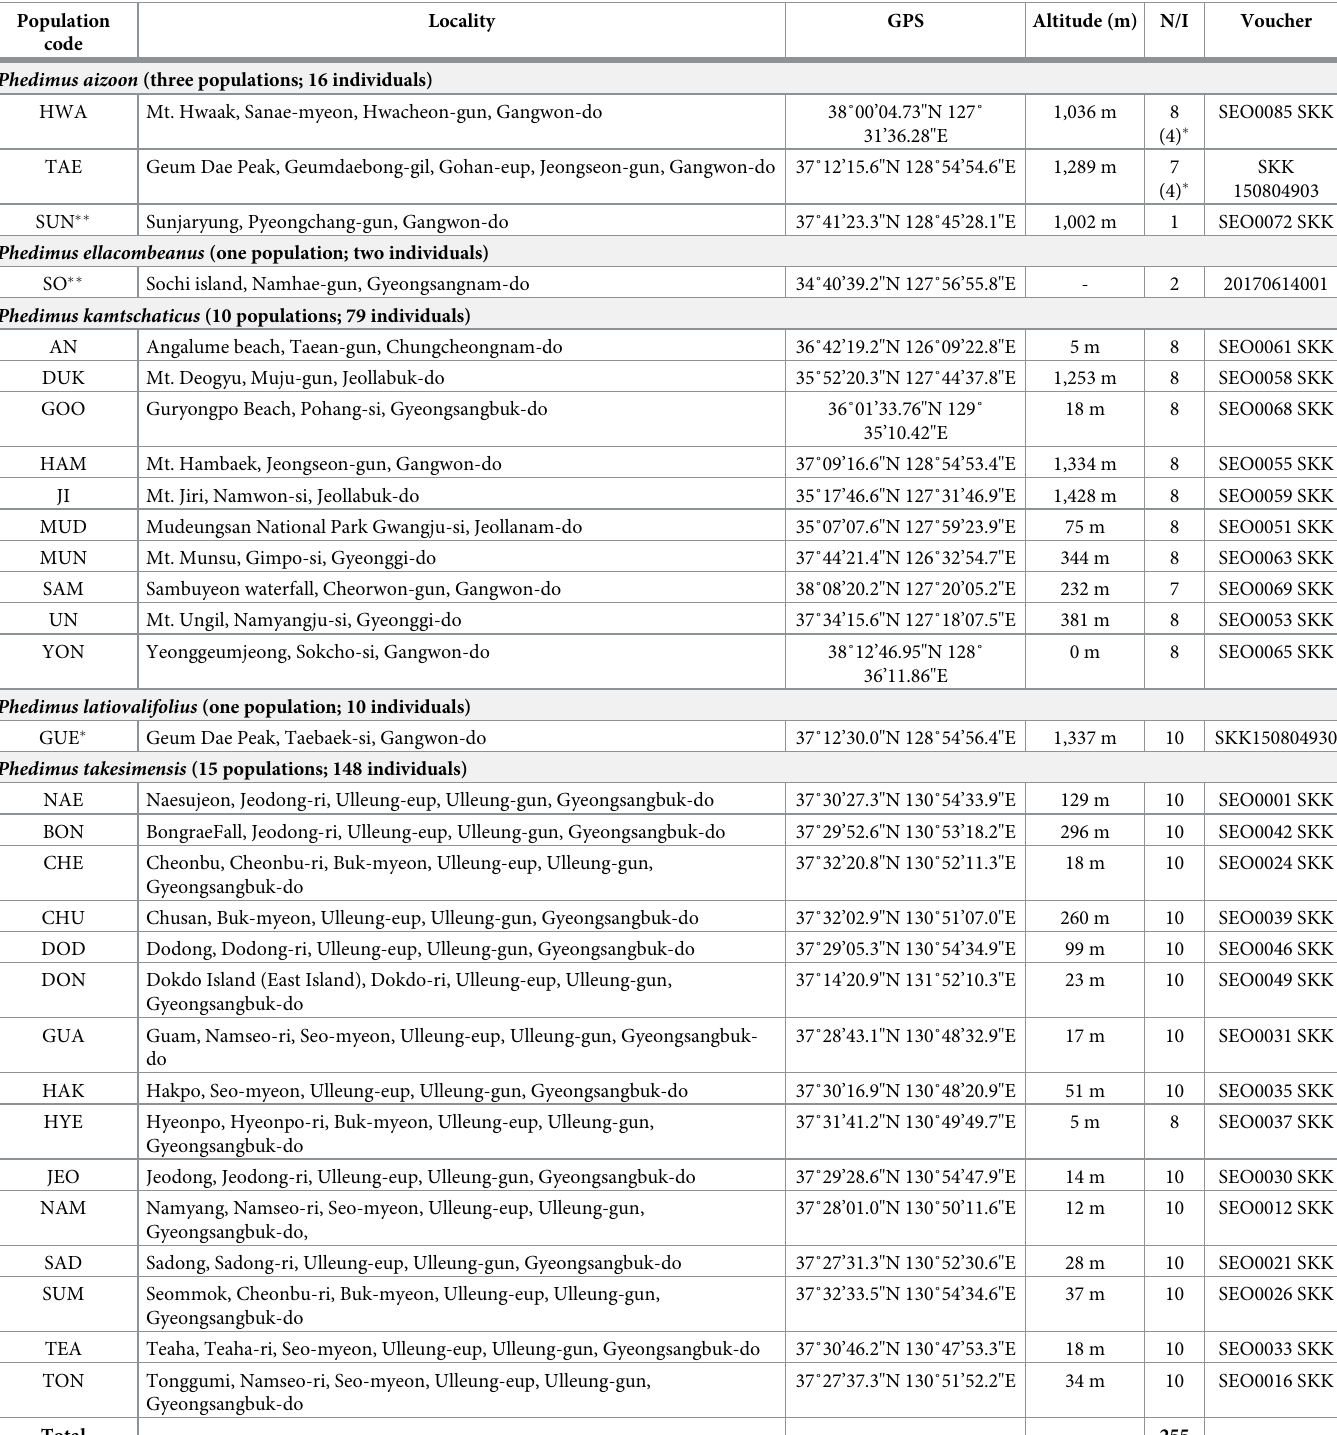
Table 1. A list of Phedimus species sampled in this study and their sampling locations. Vouchers were deposited at Ha Eun Herbarium (SKK) of Sungkyunkwan University. Population